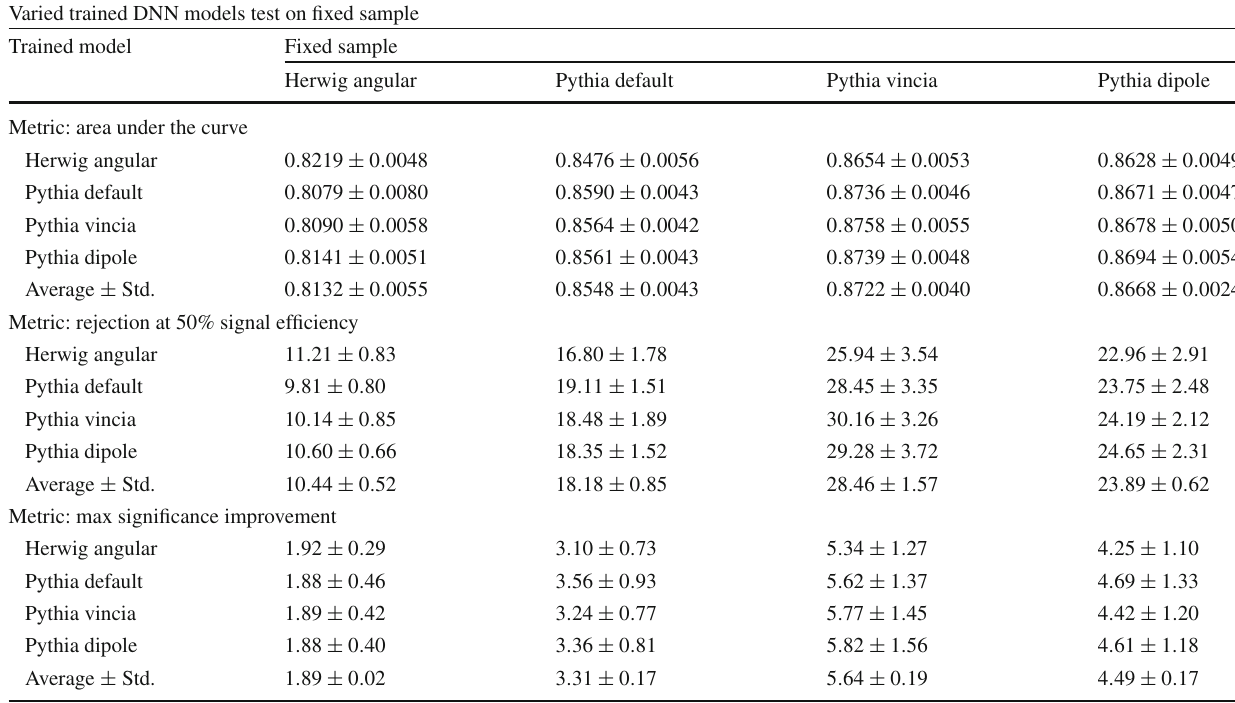
Table 6 Area under the curve, rejection at 50% signal efficiency and maximum significance improvement for the DNN model. The last rows are the average and standard deviation over the mean values from the other rows Varied trained DNN models test on fixed sample Trained